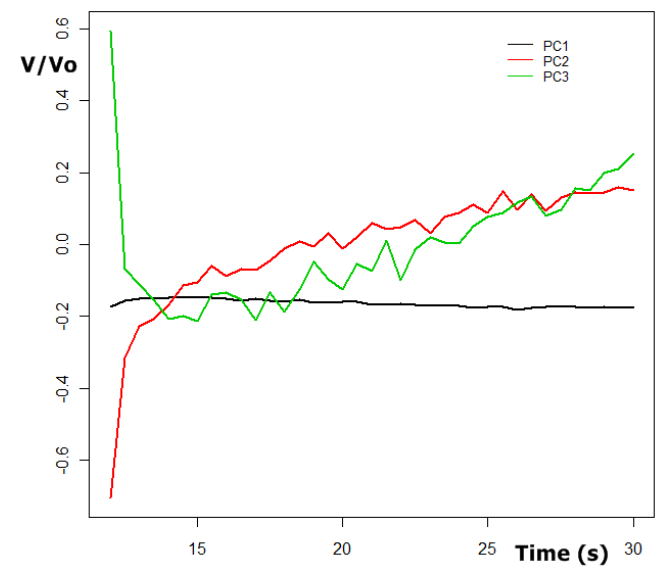
Figure 7. First three principal components of the PCA.